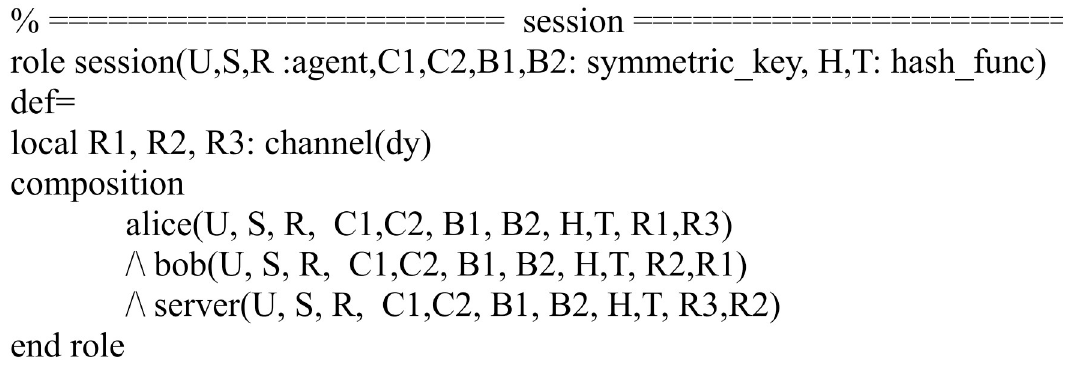
Fig 7. Role specification in HLPSL for the session.